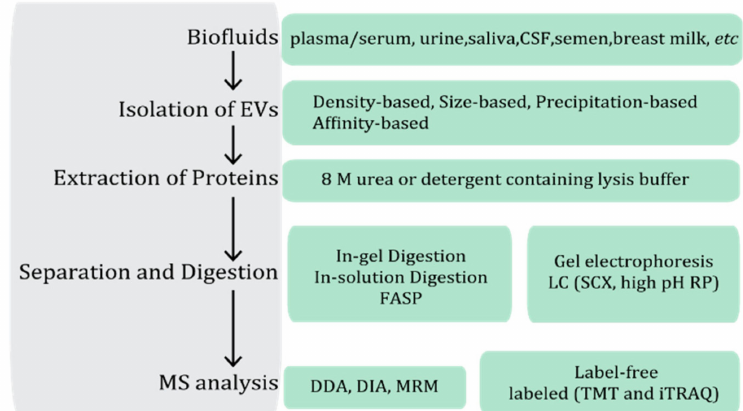
Figure 2. A general workflow of mass spectrometry (MS)-based proteomic extracellular vesicle (EV) study. EVs are firstly isolated from various biofluids, and EV proteins are extracted by adding detergent or non-detergent containing lysis bu ff er. The extracted EV proteins can be separated by gel electrophoresis and digested in-gel before MS analysis. Alternatively, digestion can be performed after protein extraction, and the generated peptides are either fractionated by liquid chromatography (LC) before MS analysis or directly subjected to MS analysis. The MS analysis can be conducted in data-dependent acquisition (DDA) or data-independent acquisition (DIA) for discovery EV studies or multiple reaction monitoring (MRM) for target EV studies. Di ff erential expressed EV proteins also can be revealed by quantitative MS analysis via label-free or labeled quantitative proteomics. CSF: cerebrospinal fluid; FASP: filter aided sample preparation; SCX: strong cation exchange chromatography; RP: reverse phase chromatography; TMT: tandem mass tag; iTRAQ: